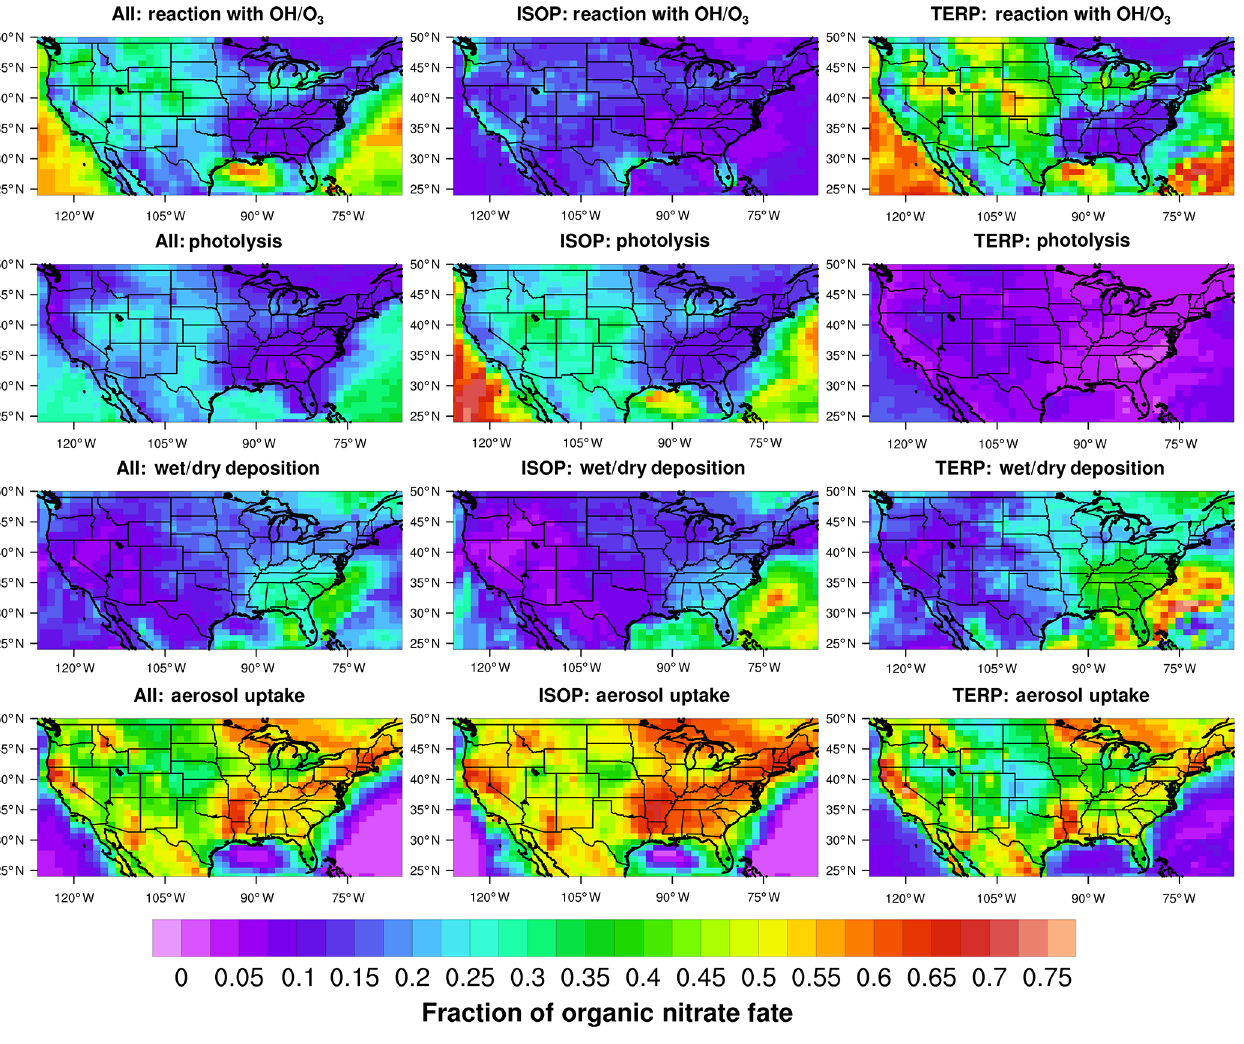
Figure 12. August 2013 average organic-nitrate fate below 2km using TS2 for all organic nitrates (left), isoprene organic nitrates (middle), and terpene organic nitrates (right). To avoid double counting, only the final fate is included, so the reaction with OH/O 3 to form another organic nitrate is omitted from this